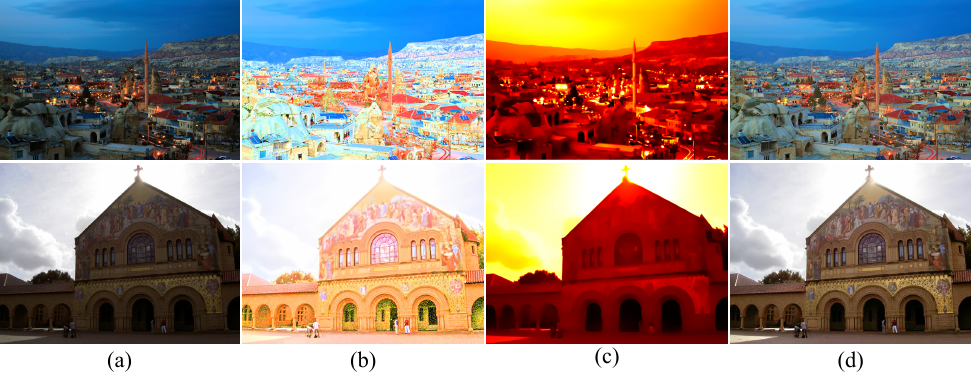
Figure 2. Visual evaluation of Retinex decomposition. ( a ) Input low-light image, ( b ) the estimated reflectance component, ( c ) the estimated illumination component, ( d ) the enhancement